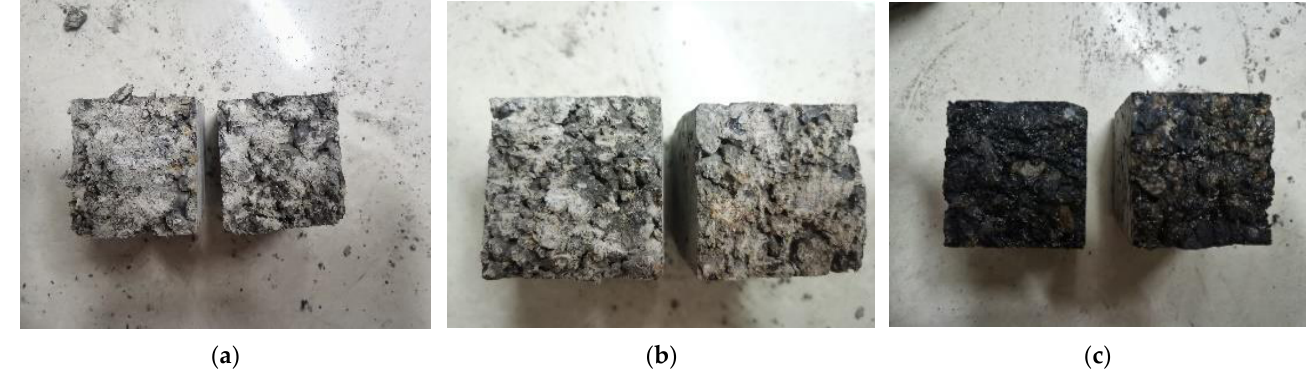
Figure 12. Failure form of the shear test after accelerated loading test. ( a ) I-6; ( b ) II-1; ( c ) II-3.